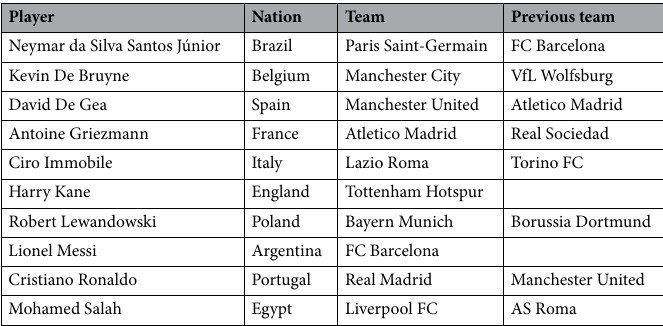
Table 1. 2017–2018 player of the season